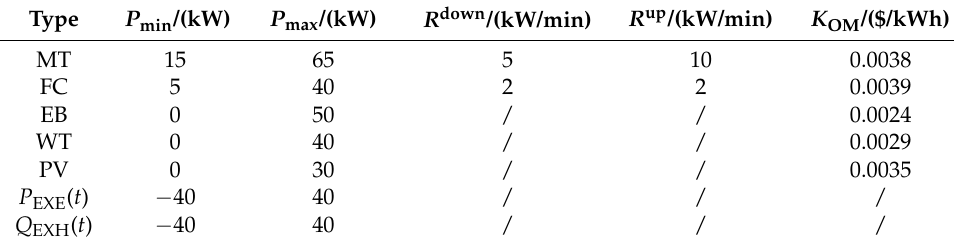
Figure 4. Forecast value of WT, PV, and load in a typical day in winter. Table 1. Operating limits of CHP-based MG system.